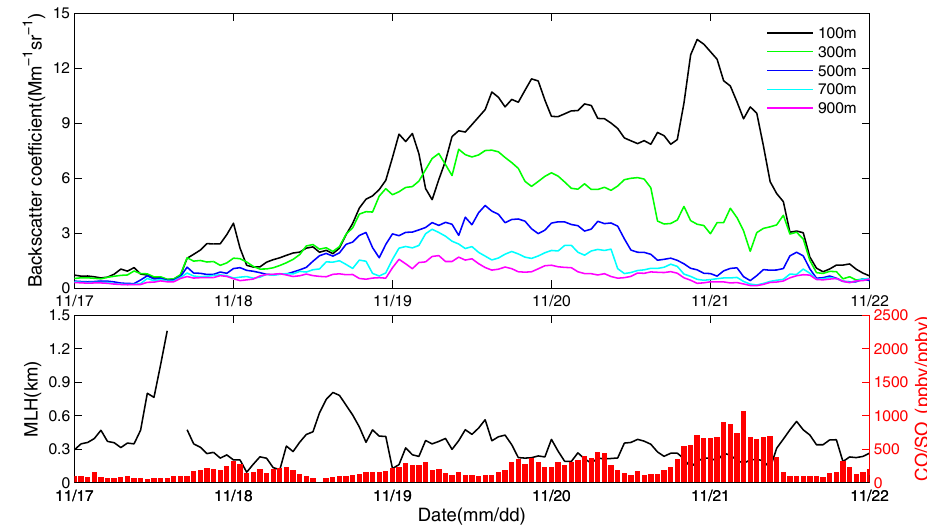
Figure 13. Attenuated backscattering coefficients at different heights and near-surface CO / SO 2 ratios from 17 to 21 November.